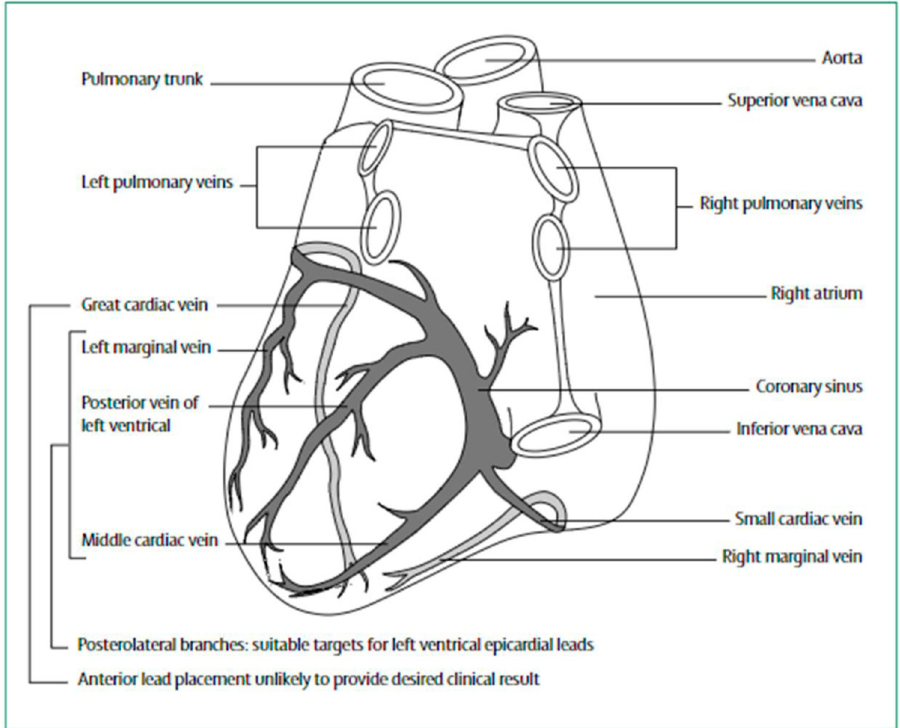
Figure 2. Diagrammatic presentation of heart showing positions for coronary venous lead placement. Reproduced with permission from reference [29].